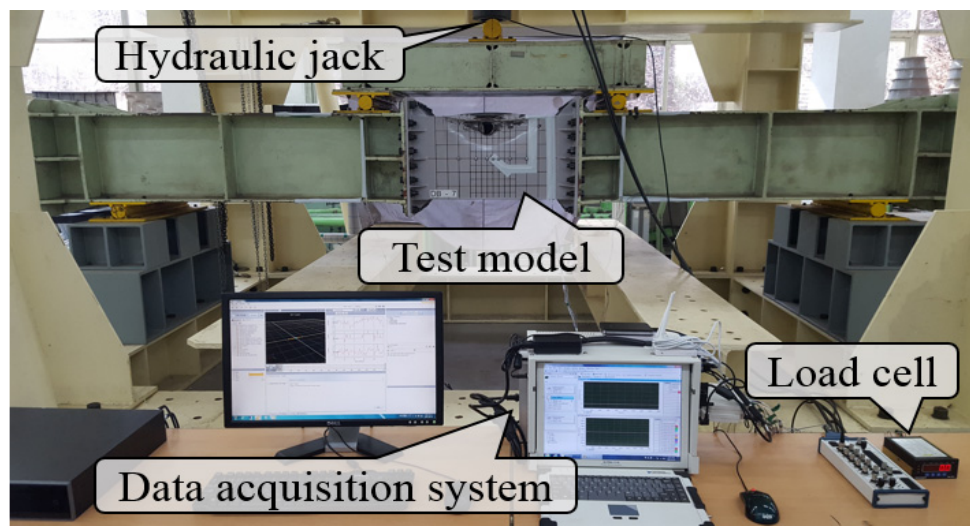
Figure 9. The four-point bending-test setup.